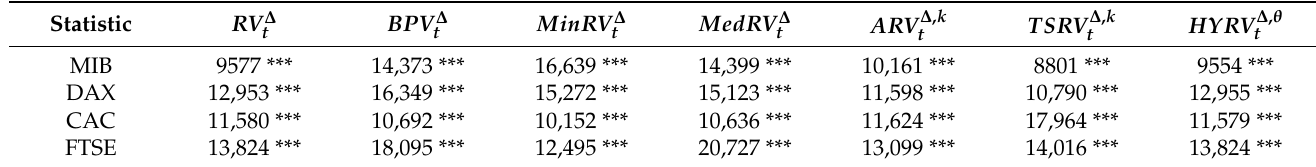
Table 5. Kolmogorov–Smirnov tests using probability integral transformations.